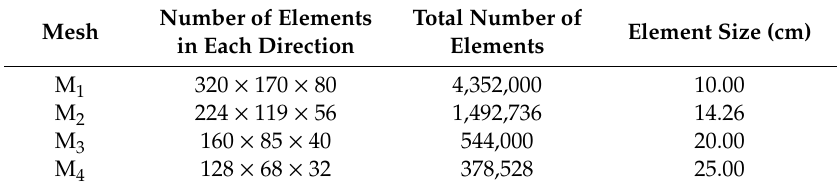
Table 4. Characteristics of the analyzed